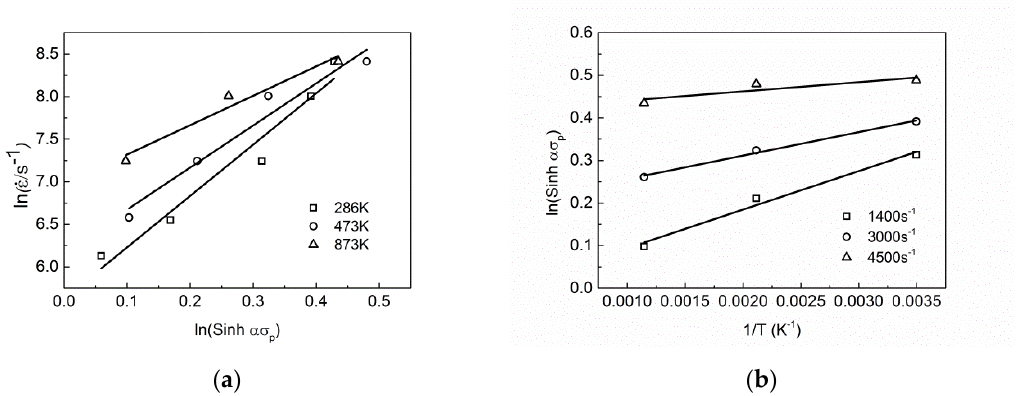
(cid:16) (cid:17) . ε sin h ασ p with ( a ) ln and ( b ) 1 / T , respectively.